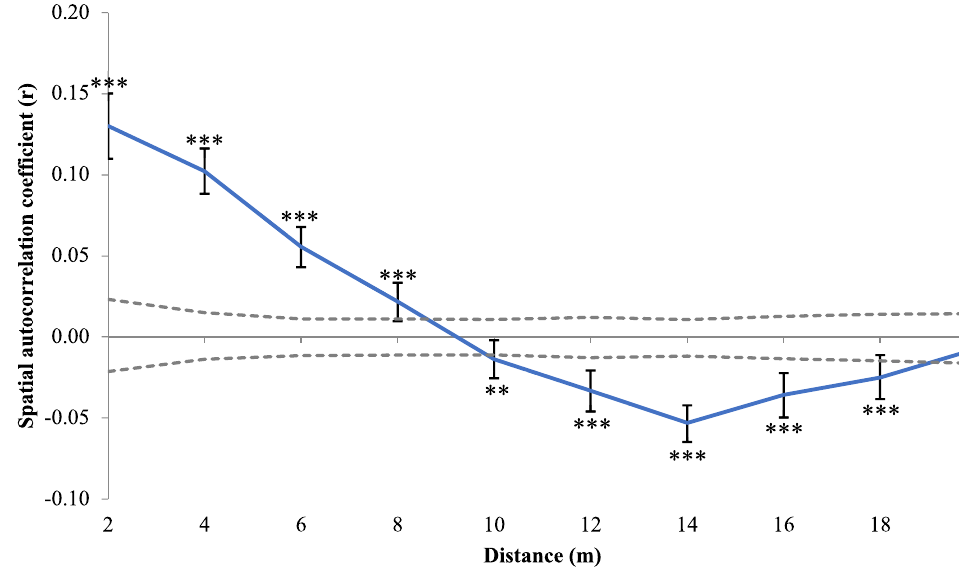
Figure 3. Spatial autocorrelation at 2 m spatial distance classes within the 400 m 2 parcel of forest on Fort Cay. Gray dashed lines denote the upper and lower null confidence interval. Asterisk denotes significant